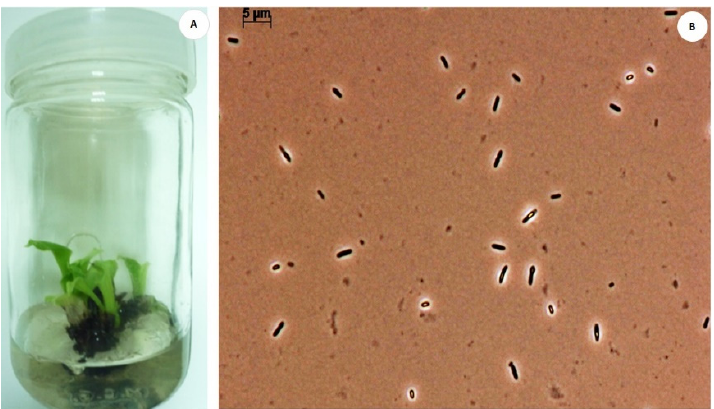
Figure 1. Representative morphology of contaminated in vitro banana culture ( A ) and spore-form- ing bacillus (Bacillus pumilus) growing on trypticase soy agar medium ( B